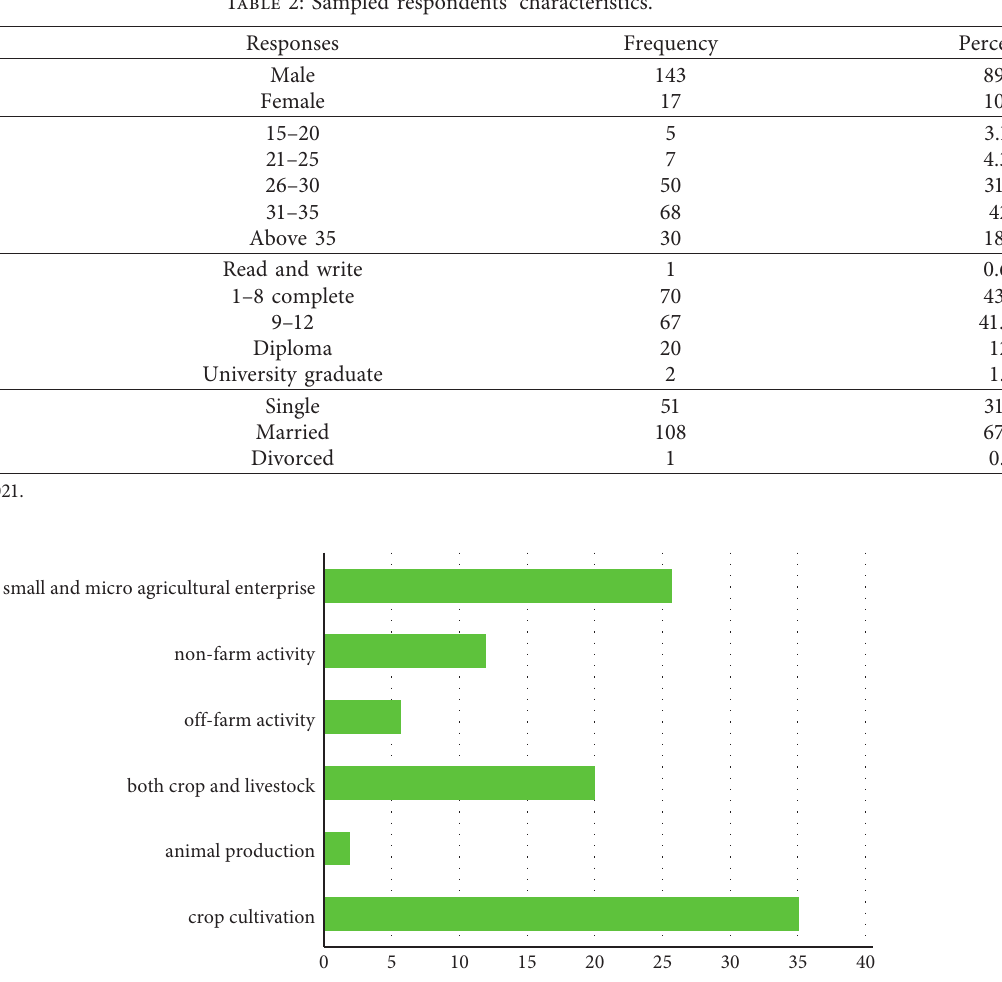
Table 2: Sampled respondents’ characteristics.